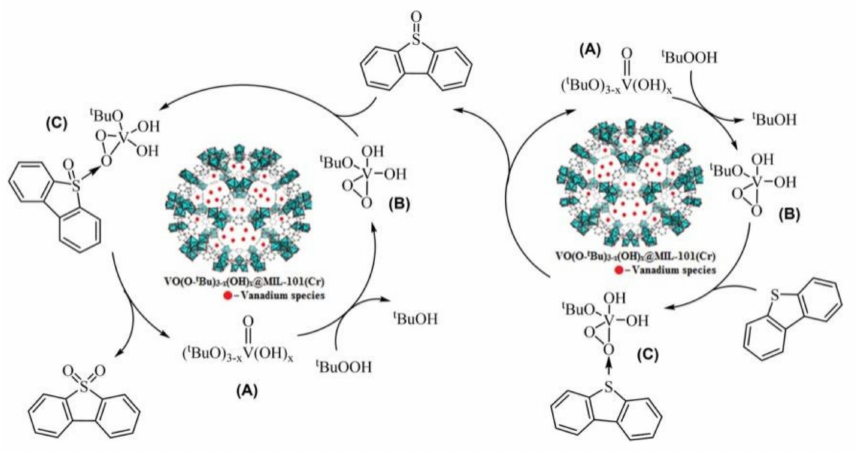
Figure 7. Proposed mechanism for ODS of DBT by OV(O t Bu) 3 − x (OH) x @MIL-101(Cr) catalyst in the presence of TBHP (reproduced from Ref. [110], copyright 2020